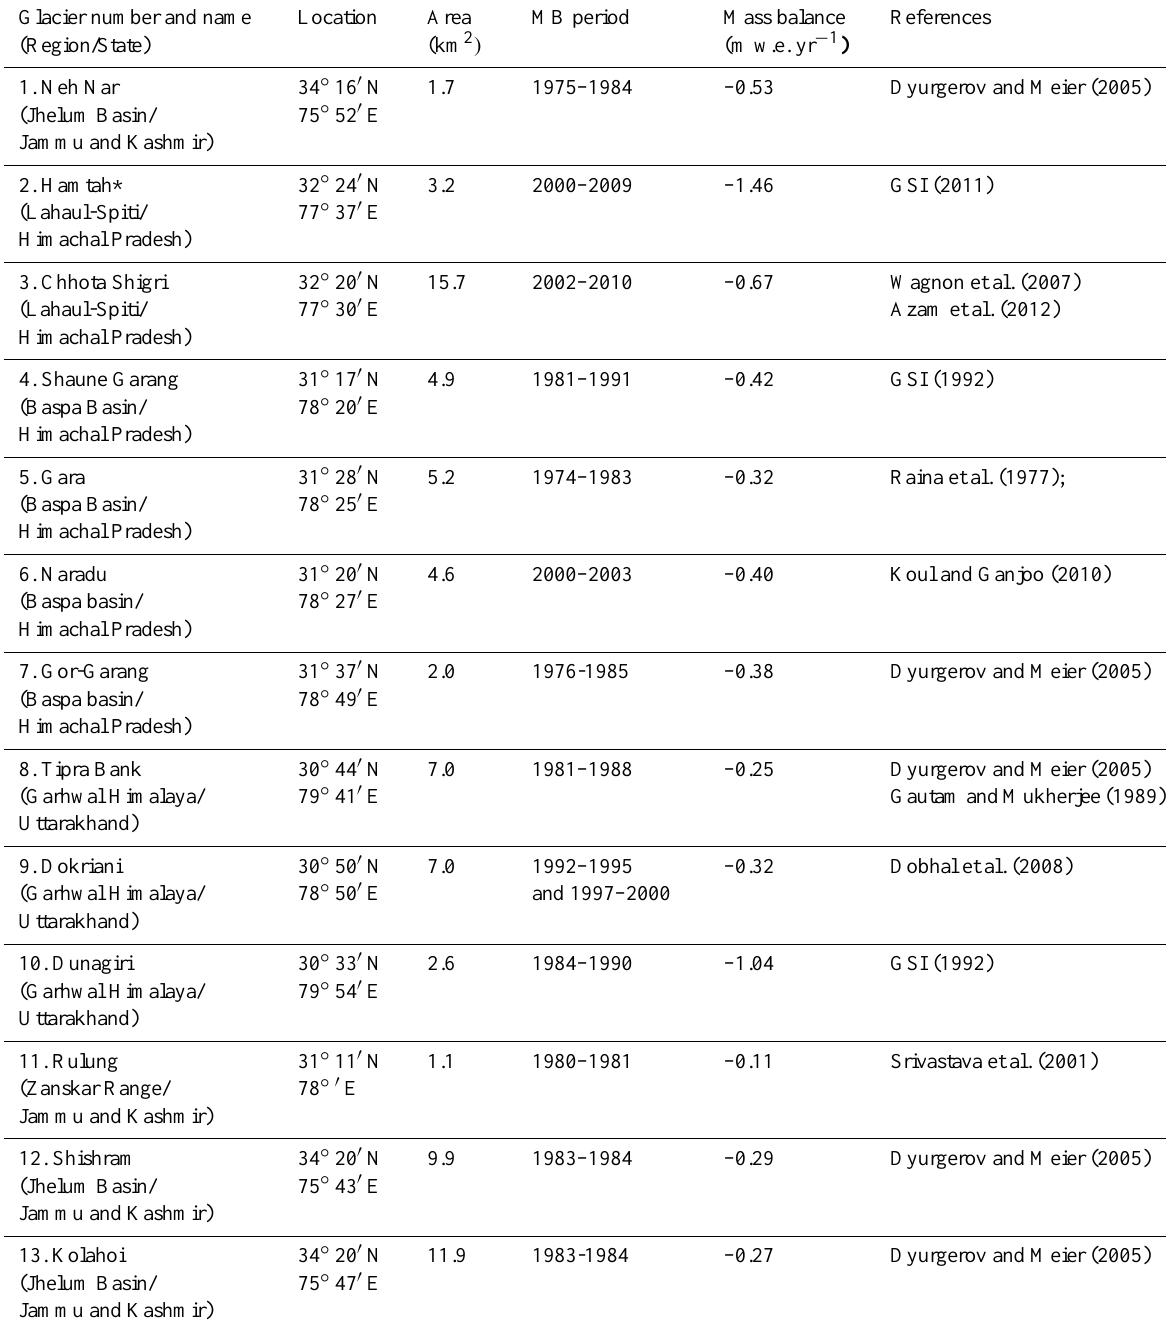
Table 1. Description of glaciers with glaciological MB series in the western Himalaya Glacier number and name